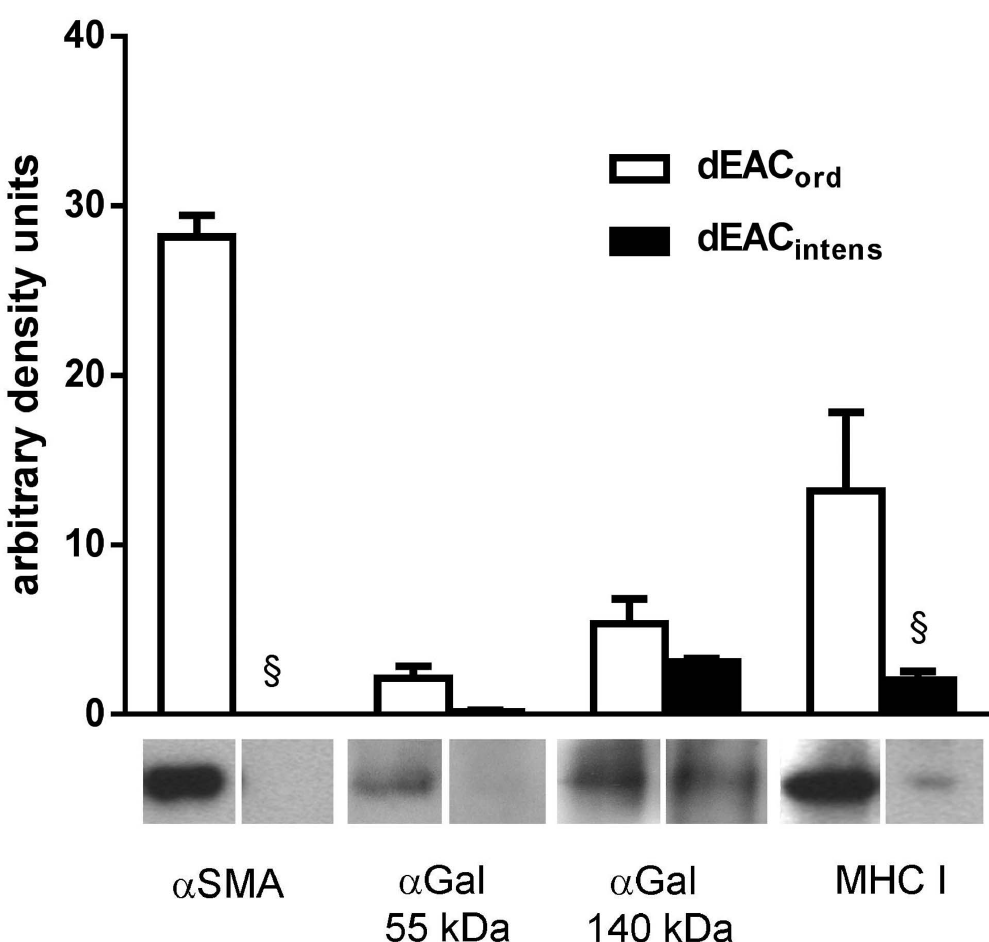
Figure 3. Western blot analyses of extracts of dEAC ord and dEAC intens . 30 m g of protein were separated on SDS-PAGE, transferred to PVDF membrane and probed by the indicated antibodies or peroxidase-linked Bandeiraea simplicifolia isolectin B4 for a Gal detection. Bands of three different carotids were quantified densitometrically and shown as the means 6 SEM. 1 : p , 0.0001 by two-way ANOVA and Bonferroni post test.